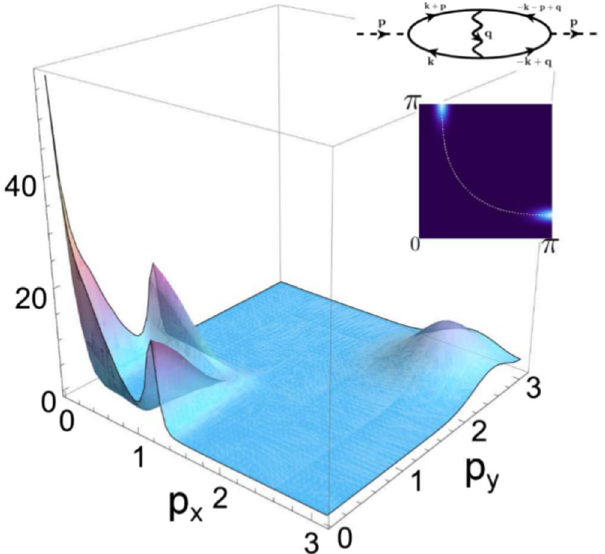
in the positive quarter of 0